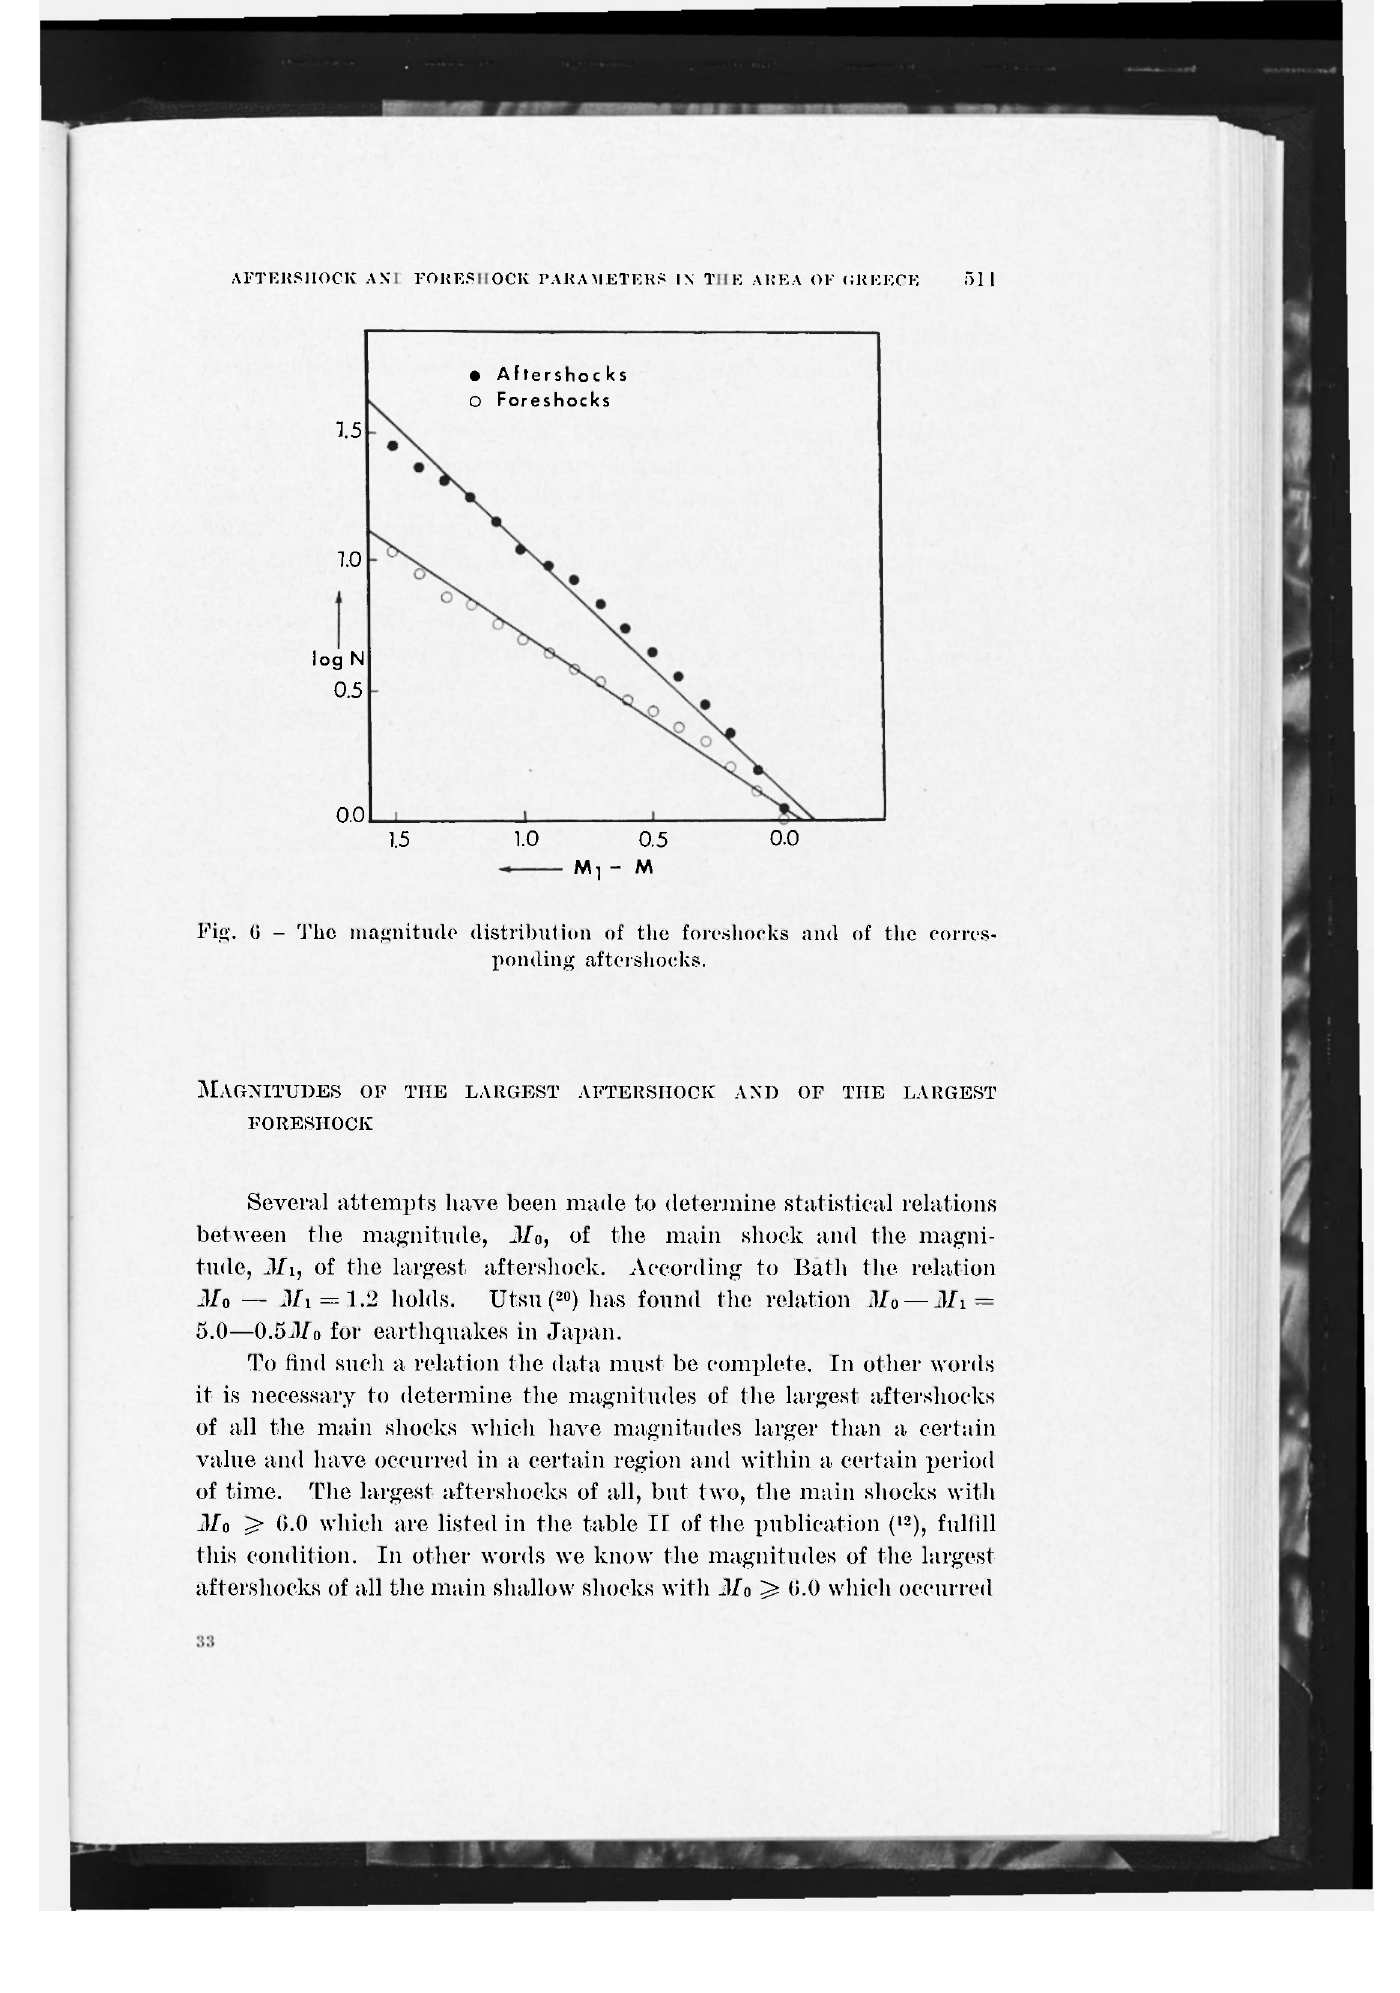
Fig. 0 - The magnitude distribution of the foreshocks and of the corres- ponding